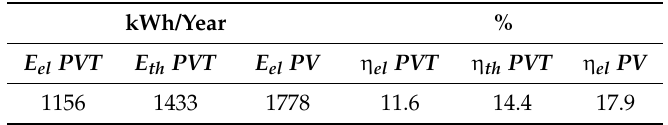
Table 5. Yearly energy results.